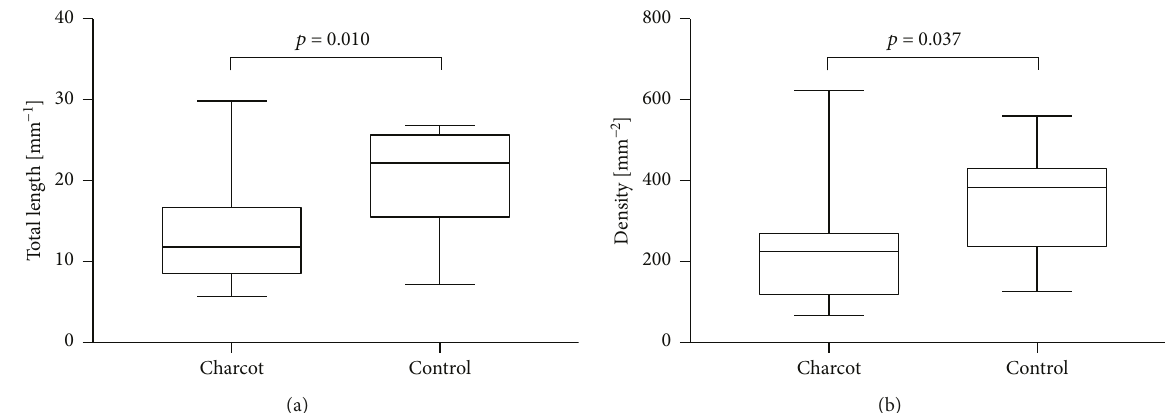
Figure 2: Corneal nerve fi bre length de fi ned as the total length of all nerve fi bres (mm/mm 2 , p = 0 010 ) (a) and corneal nerve fi bre density de fi ned as the number of nerve fi bres per mm 2 ( p = 0 037 ) (b) in Charcot and control groups.